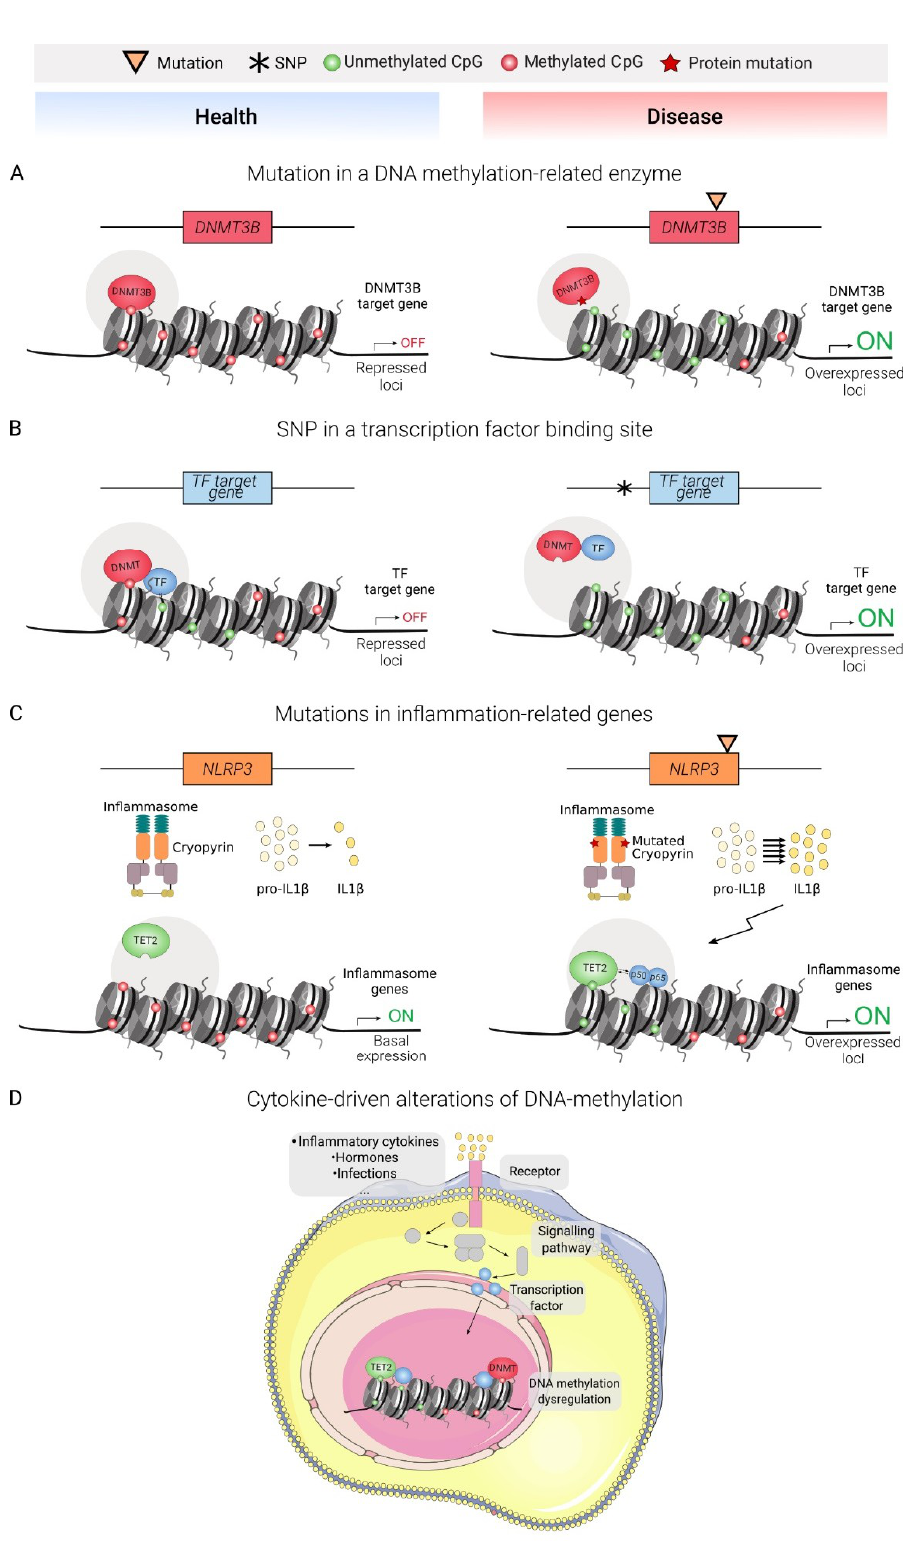
Figure 2. Proposed theoretical models of association between genetic and epigenetic determinants of immune diseases. ( A ) Mutations in genes encoding for components of the DNA methylation machinery, ( B ) polymorphisms in TFBS altering TF binding capacity, and ( C ) mutations in inflammation-related proteins with impact on DNA methylation. ( D ) External inflammatory stimuli with impact in DNA methylation.